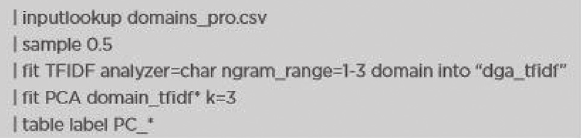
Figure 7: SPL commands in Splank based on the TFIDF model.